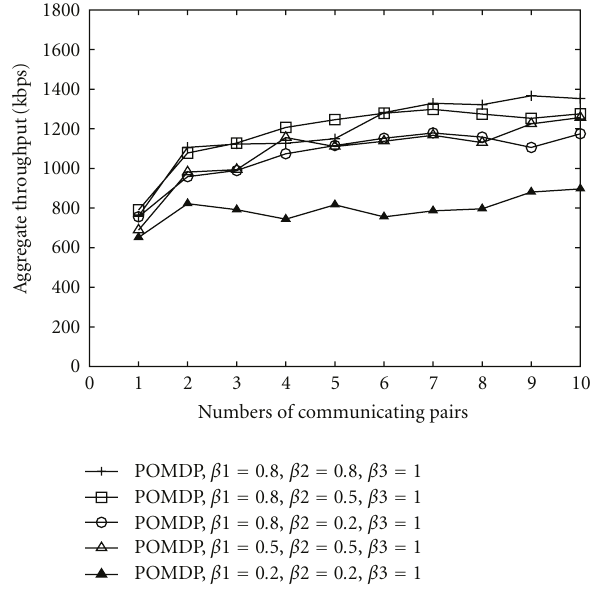
Figure 18: Aggregate throughput of POMDP with 2 channels having PUs’